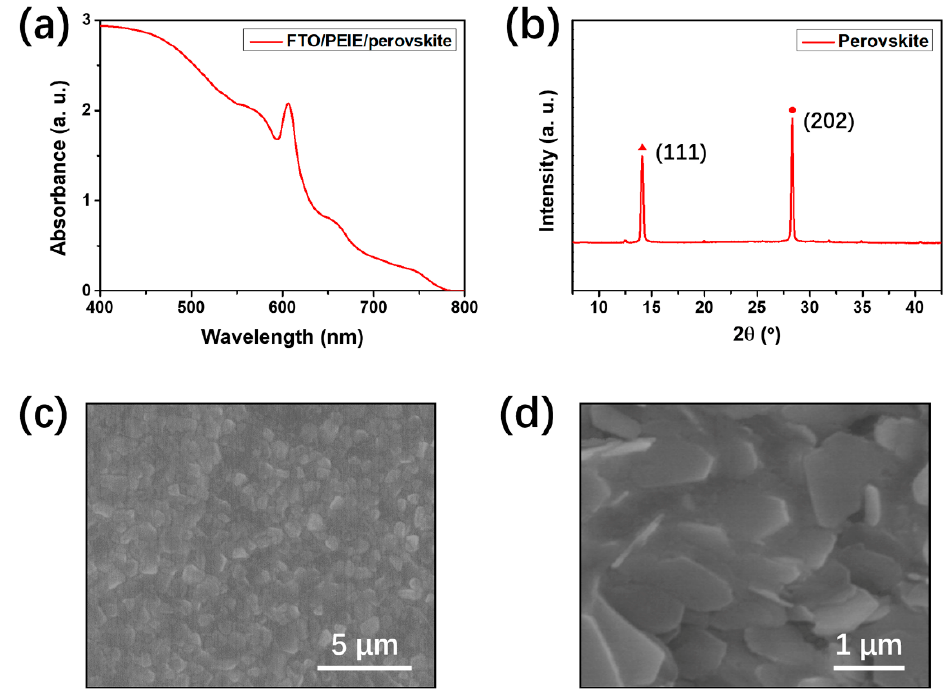
Figure 3. UV − vis spectrum ( a ) and XRD pattern ( b ) of the prepared (BA) 2 (MA) 3 Pb 4 I 13 perovskite film; Low ( c ) and high ( d ) magnified SEM images of the prepared (BA) 2 (MA) 3 Pb 4 I 13 perovskite layer on FTO/PEIE substrate.